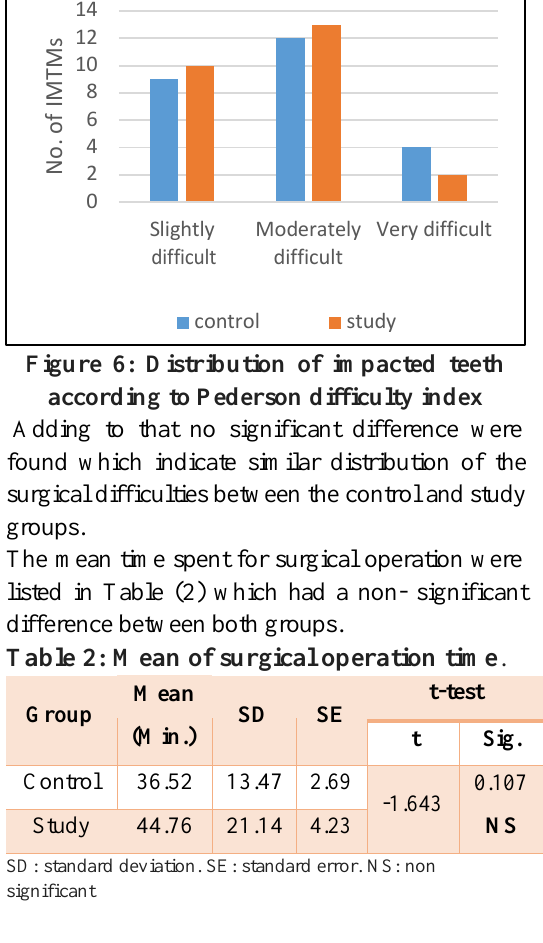
Table 5: Incidence of alveolar